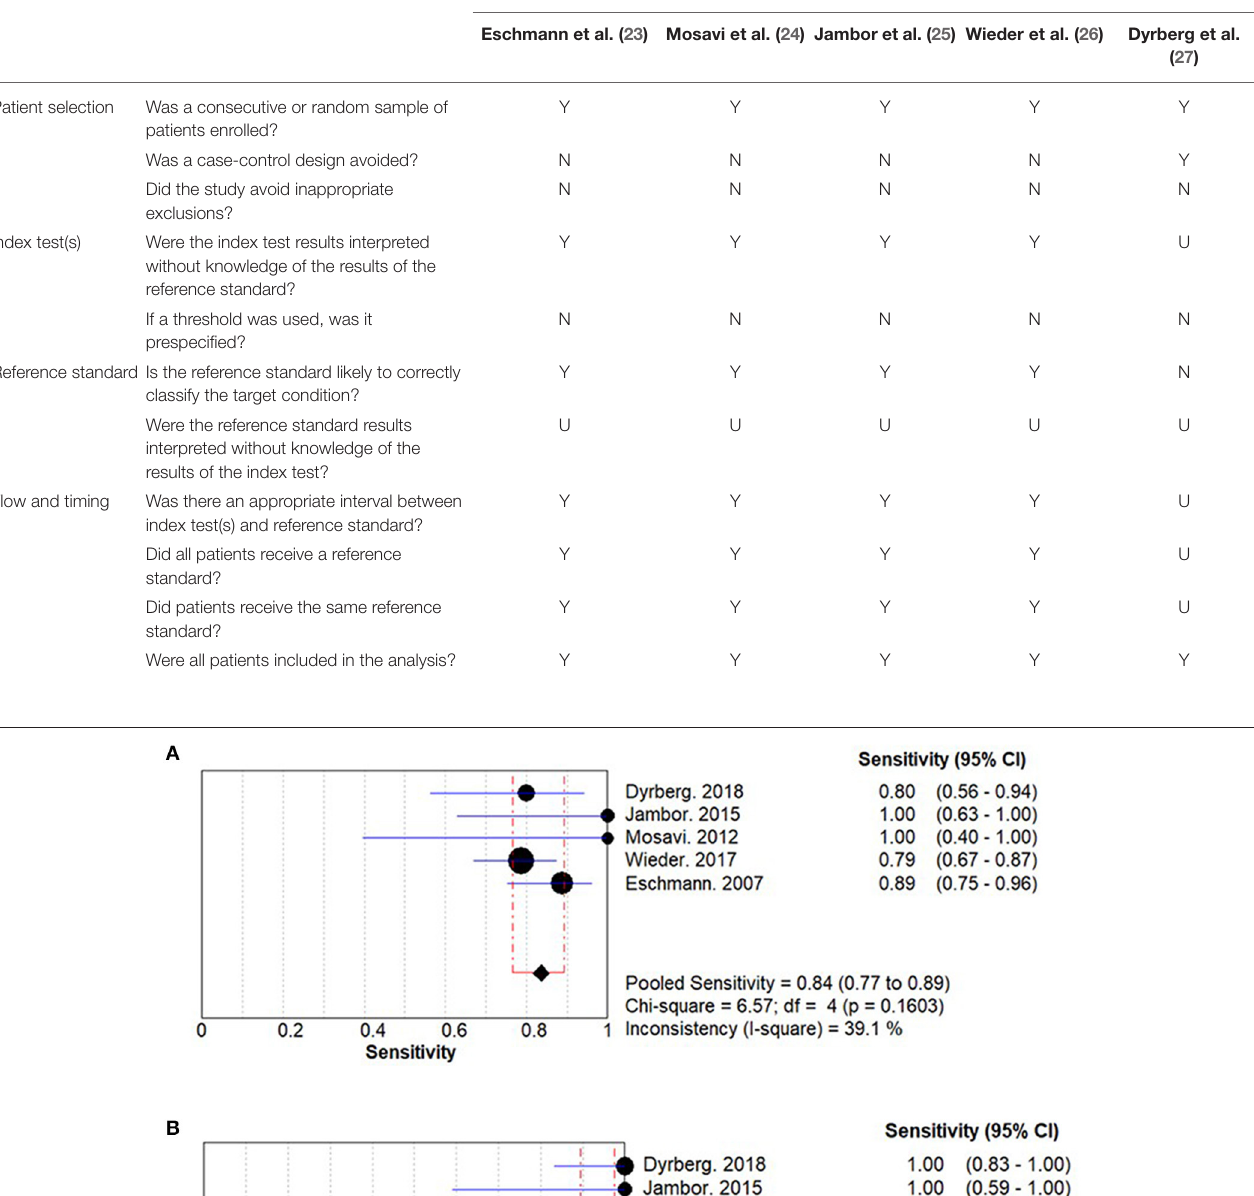
TABLE 2 | Quality evaluation of the included studies using the QUADAS-2 tool.